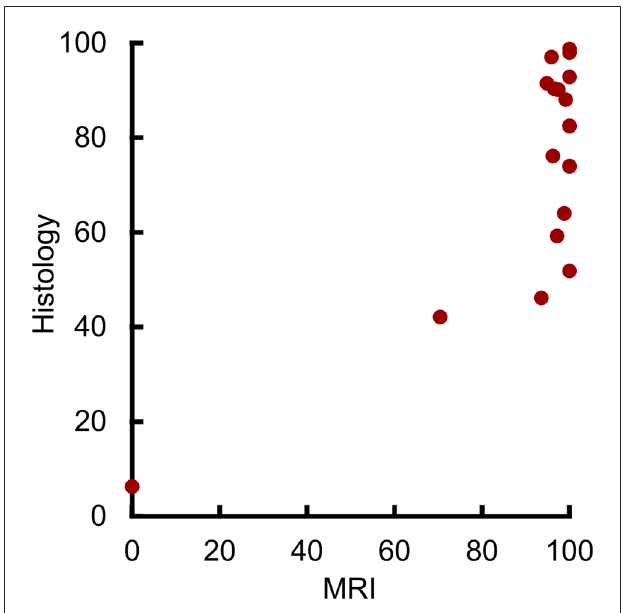
FIGURE 3 | MRI hypersignal did not linearly predict amygdala damage. Percent of amygdala damage as estimated by T2 MRI and by histological examination. Each dot represents one hemisphere ( n = 19).